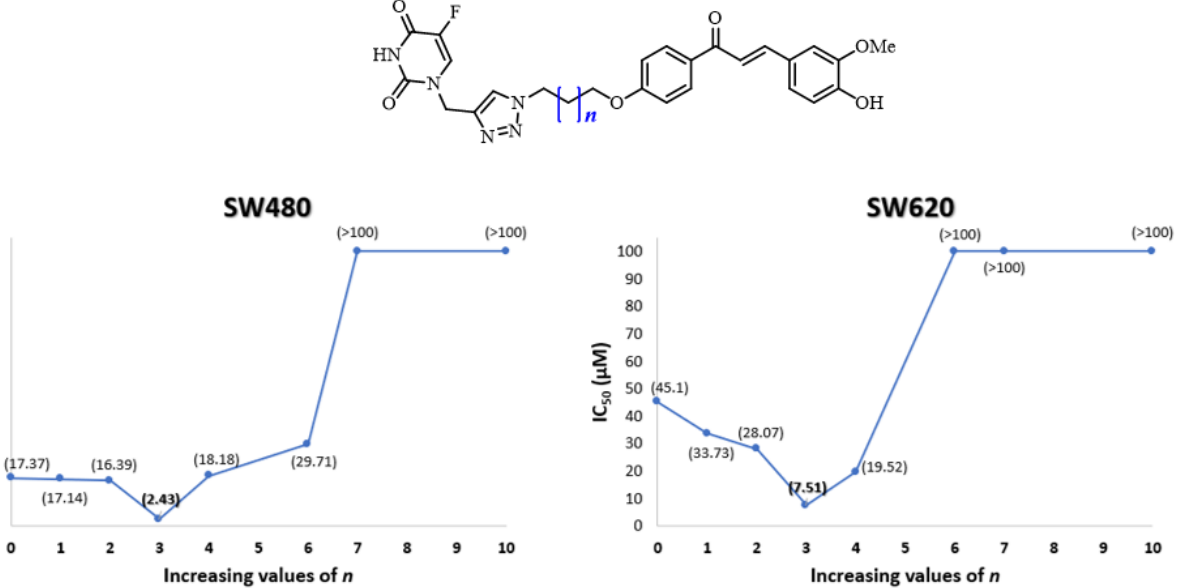
Figure 4. Variation of the treatment response curve with increasing carbon number. The values in parentheses correspond to the IC 50 values of the hybrid compounds [36]. Table 1. Cytotoxic e ff ect of 5-FU/Curcumin hybrids on SW480, HaCaT, and CHO-K1 cell lines.